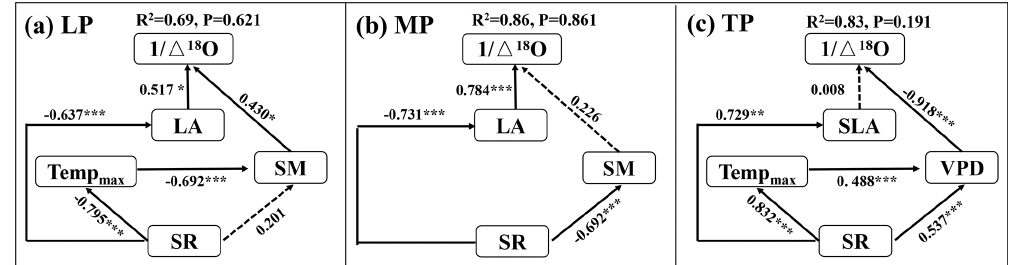
Figure 5. Structural equation models of abiotic and biotic factors explaining community 1 /(cid:49) 18 O on the Loess Plateau (LP) (a) , the Inner Mongolian Plateau (MP) (b) , and the Tibetan Plateau (TP) (c) . The variables mentioned in the figure are as follows: (cid:49) 18 O – 18 O enrichment above the source water of leaf organic matter, Temp max – maximum temperature, SR – solar radiation, SM – soil moisture, VPD – vapor pressure deficit, LA – log-transformed leaf area, and SLA – log-transformed specific leaf area. The solid and dashed arrows represent significant and non-significant relationships in a fitted SEM, respectively. “ ∗∗∗ ” denotes P< 0 . 001, “ ∗∗ ” denotes P< 0 . 01, and “ ∗ ” denotes P< 0 .